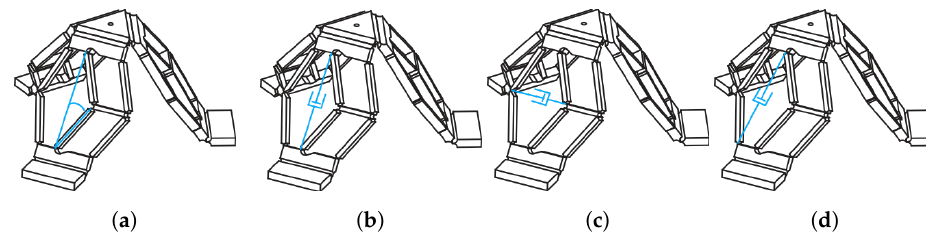
Figure 3. From the left, the three steps of plastic deformations at the hinges level that allows obtaining the final configuration of the mini-manipulator.